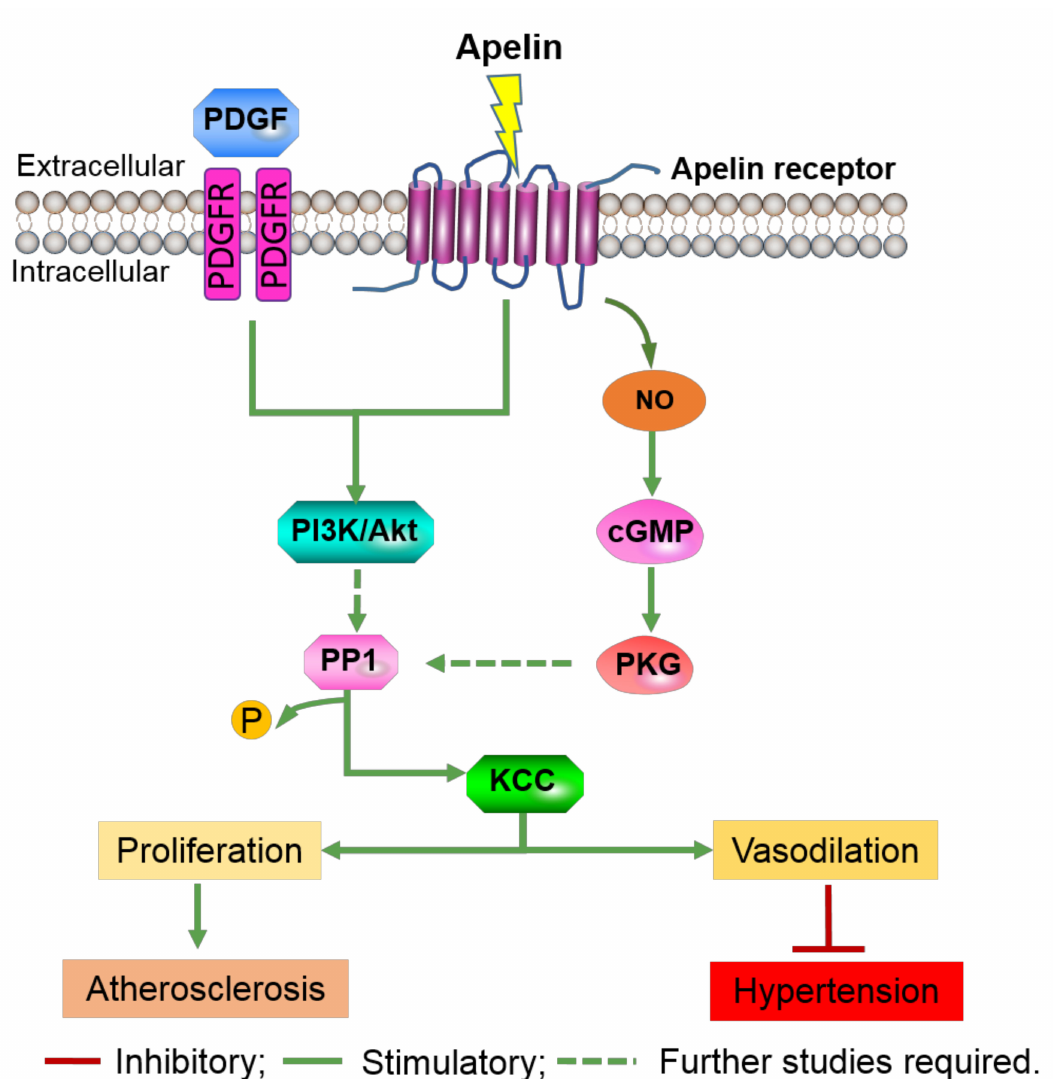
Figure 2. KCC is implicated in atherosclerosis and is a potential therapeutic target for hypertension. Potassium chloride channel (KCC) in vascular cells is regulated via the platelet-derived growth factor (PDGF) and nitric oxide (NO), both of which are implicated in atherosclerosis and vasodilation respectively. PDGF regulates KCC through the dimerization of PDGF receptors (PDGFR) and the subsequent activation of phosphoinositide 3-kinase (PI3K). Through an unknown mechanism, PI3K activates protein phosphatase 1 (PP1) which dephosphorylates and actives KCC. Activation of KCC could enhance the phenotypic switching of vascular smooth muscle cells (VSMCs) into a diseased state. NO regulates KCC via the nitric oxide / cyclic guanosine monophosphate / protein kinase G (NO / cGMP / PKG) pathway. PKG activates PP1 through an unknown mechanism leading to KCC activation and consequent vasodilation. KCC could be a potential therapeutic target for hypertension. Apelin is cardioprotective and a common modulator of both